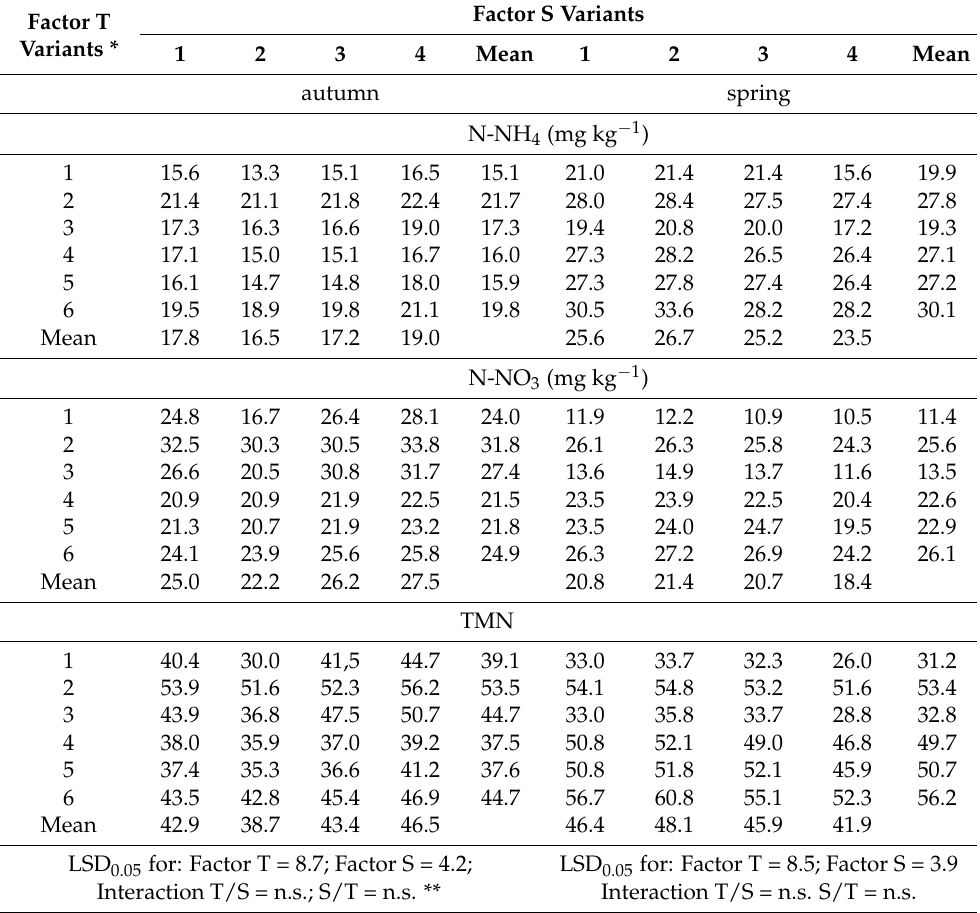
Table 2. Content of N-NH 4 , N-NO 3 , and total mineral nitrogen (TMN) (mg kg − 1 ) in the soil, depending on the tillage method (factor T) and stubble management (factor S) under spring wheat cultivation in autumn and